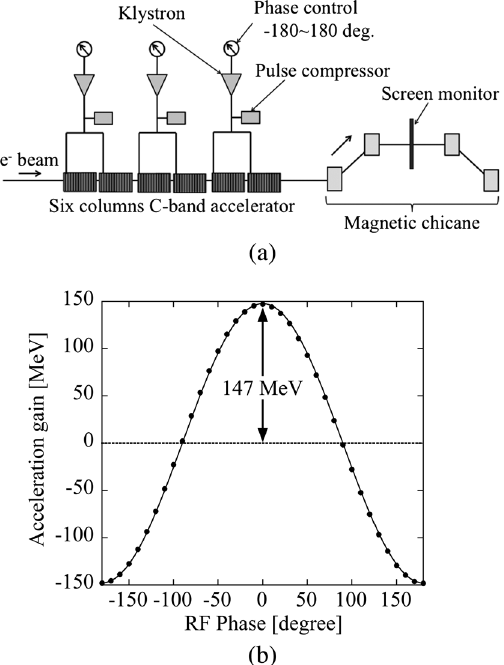
FIG. 15. (a) Schematic diagram of the C -band accelerator section in the EUV-FEL accelerator. (b) Acceleration energy gain of the two 1.8-m-long C -band accelerating structures as a function of the rf phase. The maximum acceleration energy gain is 147